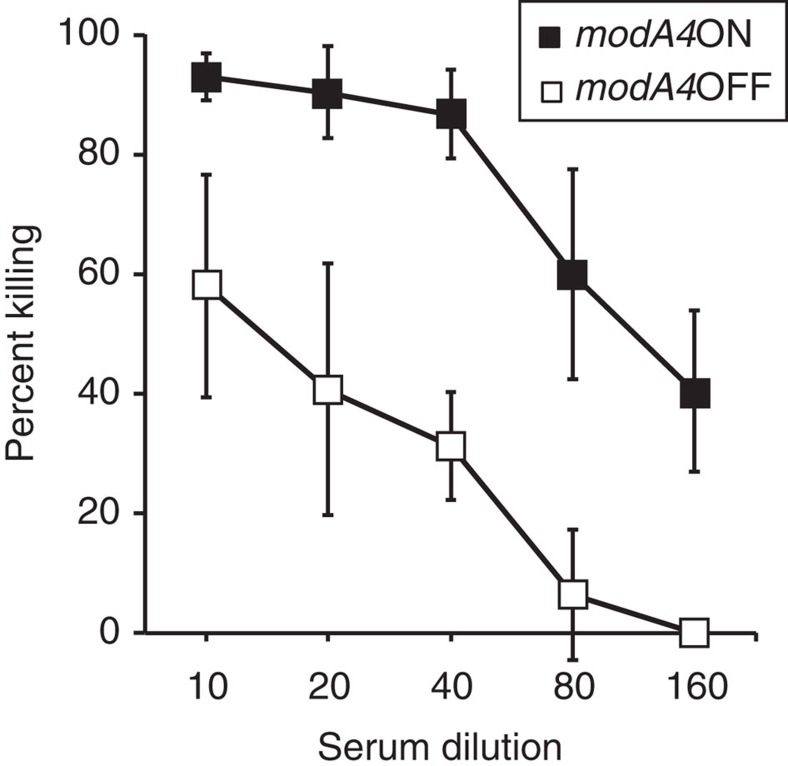
Opsonophagocytic killing curves using strain C486 modA4 ON/OFF strain pair.Assays were carried out using guinea pig antiserum raised against purified HMW proteins from NTHi strain 12, with NTHi strain C486 harbouring the modA4 ON/OFF pair. Three independent assays were carried out per strain, with error bars representing one s.d. Statistical significance was calculated using Student's t-test, and was <0.05 at all dilutions of antiserum. Individual P values—1:10=0.034; 1:20=0.0185; 1:40=0.0012; 1:80=0.009; 1:160=0.0065.